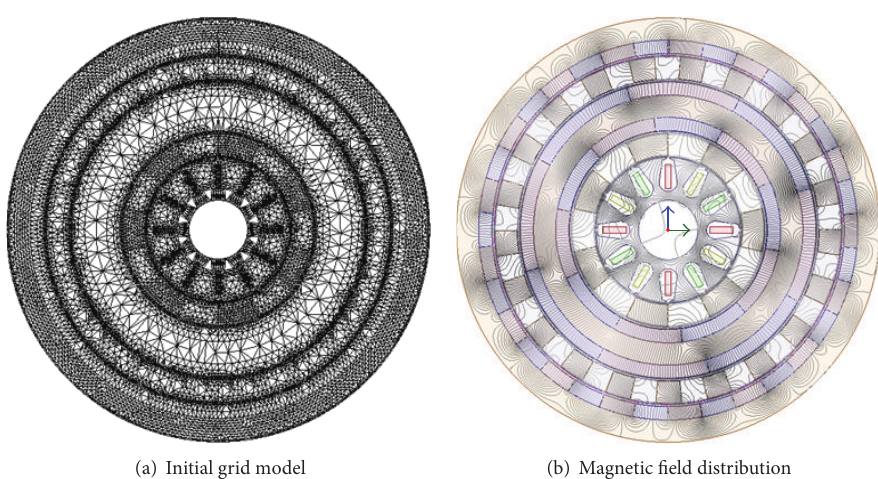
Figure 2: Finite element model of the example EIMG